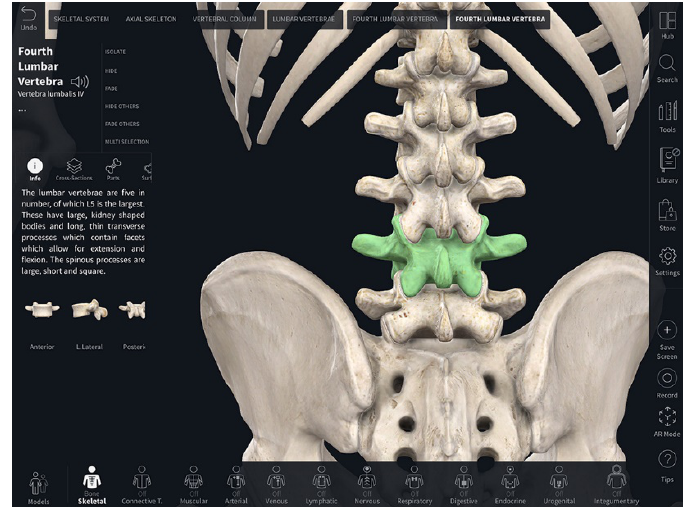
Image courtesy of Complete